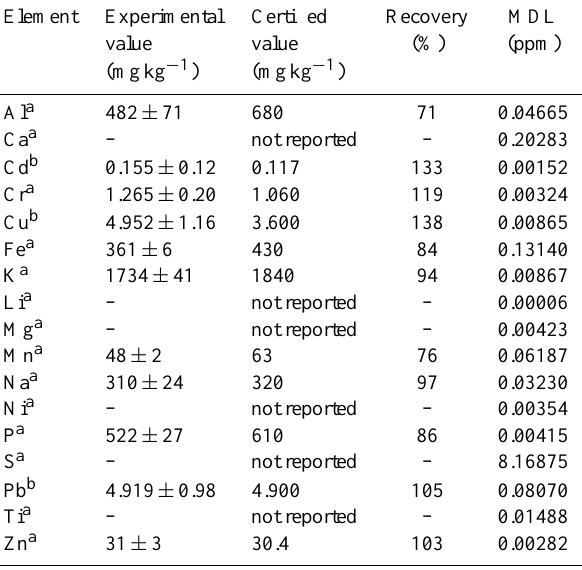
Figure 2. Exposed to control (EC) ratios calculated for the trace element concentrations measured in lichen samples after 6- and 12- month